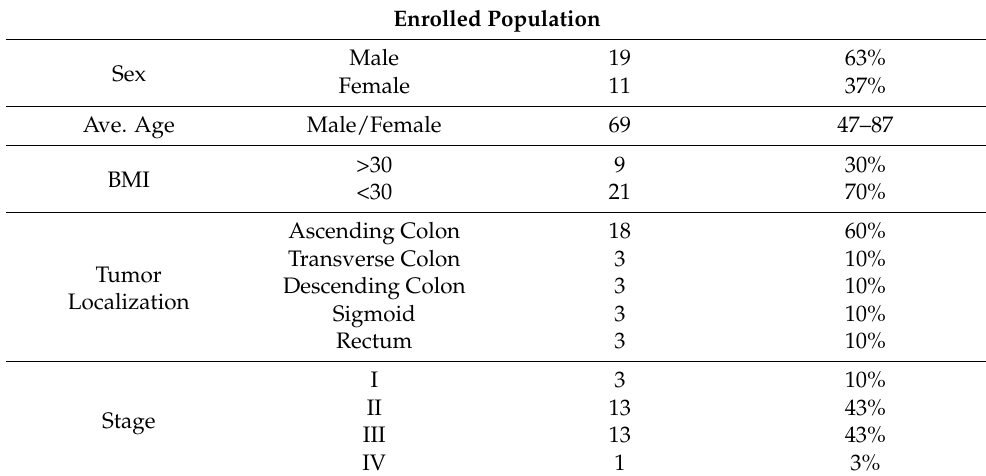
Table 1. The composition of the randomized enrolled population. AVE. AGE is the average population age; BMI is the body mass